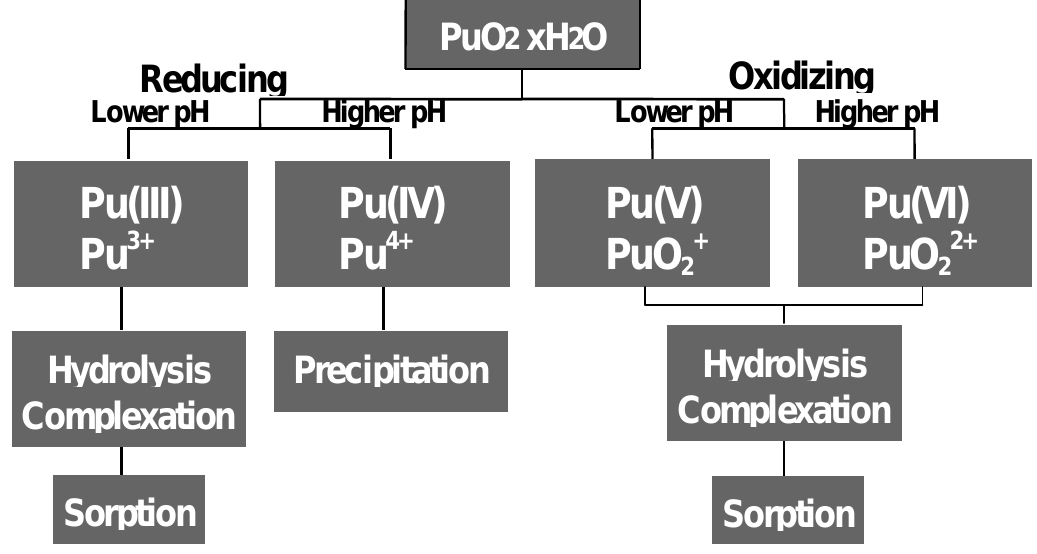
FIGURE 1. Speciation diagram for the range of reactions to be considered in studying the environmental behaviour of